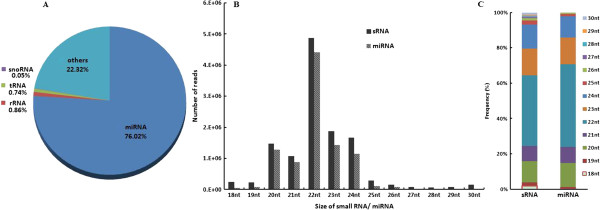
Detected small RNAs. A pie graph showing the relative abundance of different classes of small RNAs (A); size distribution of small RNAs or miRNAs (B); frequency distribution of each size (18–30 nts) of small RNAs or all known miRNAs based on all reads (C). miRNA here only indicates known bovine miRNAs in miRBase (Release 19).